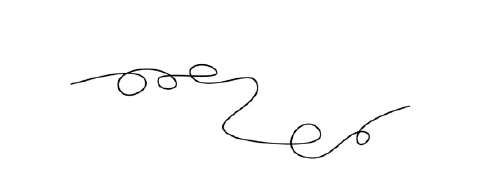
Figure 4. A second example of moving dot that generates an active line. The movement is again circular.